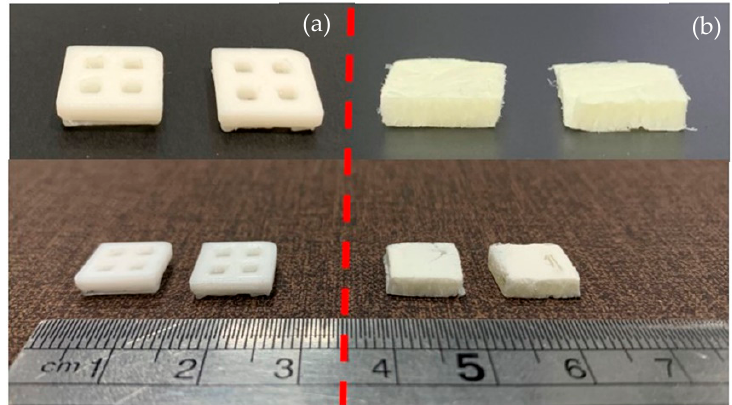
Figure 11. 3D-printed specimen ( a ) without a silk fibroin (SF) coating and ( b ) with a SF coating.